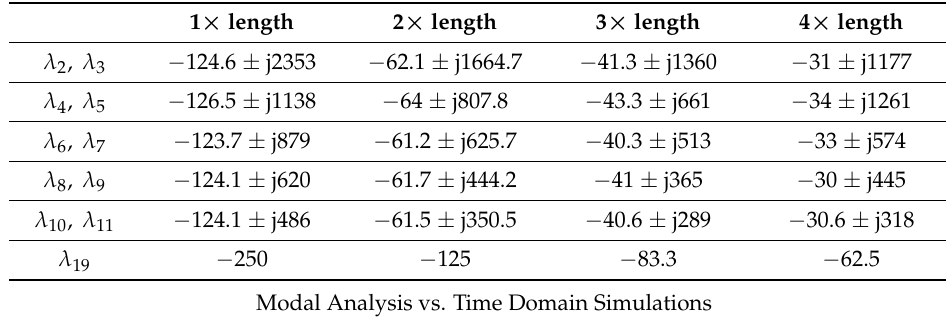
Table 3. Influence of the Inductance of MTDC